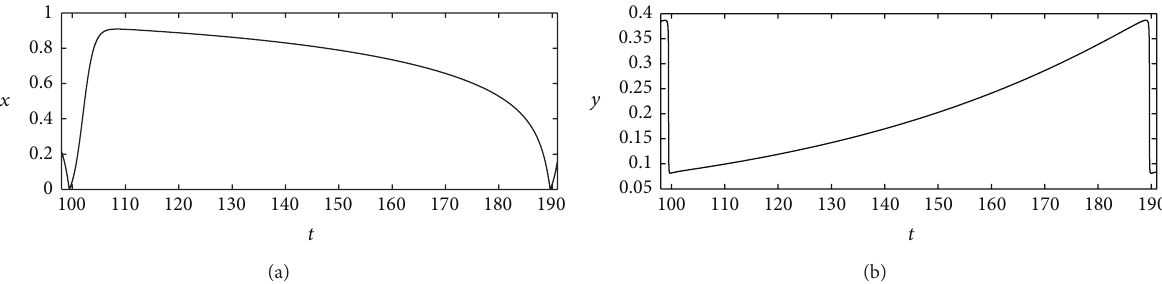
Figure 3: The curves of 𝑥 = 𝑥(𝑡) and 𝑦 = 𝑦(𝑡) obtained by locally enlarging the curves of 𝑥 = 𝑥(𝑡) and 𝑦 = 𝑦(𝑡) in Figure 2, respectively.